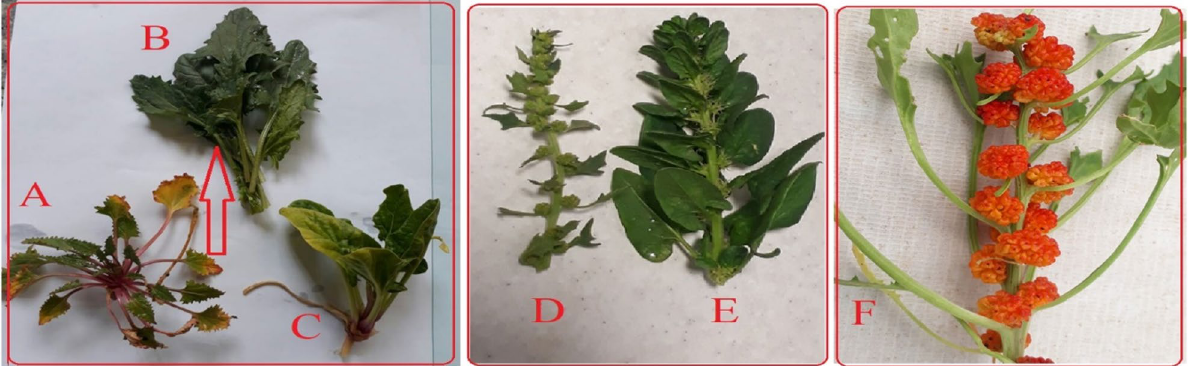
Figure 3. The sample of mother wild population ( A ) and mass-selected domesticated population ( B ), the common spinach-Varamin 88 ( C ), flowering stem in domesticated spinach ( D ), flowering stem in cultivated spinach ( E ), and mature fruits of mass selected spinach ( F ).